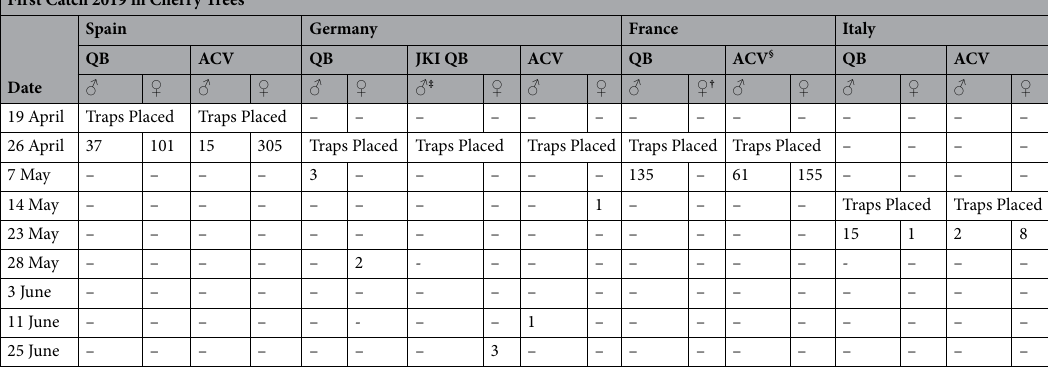
Table 2. Week, date, and number of males and females of first capture of D. suzukii by different traps within Cherry orchards in Spain, Germany, France, and Italy in 2019. QB are sticky traps baited with USDA quinary blend, JKI QB are traps baited with USDA QB blend + 200 ml tap water and 1% boric acid, and ACV are traps baited with apple cider vinegar. †Due to the difficulty in detecting female SWD on sticky traps female